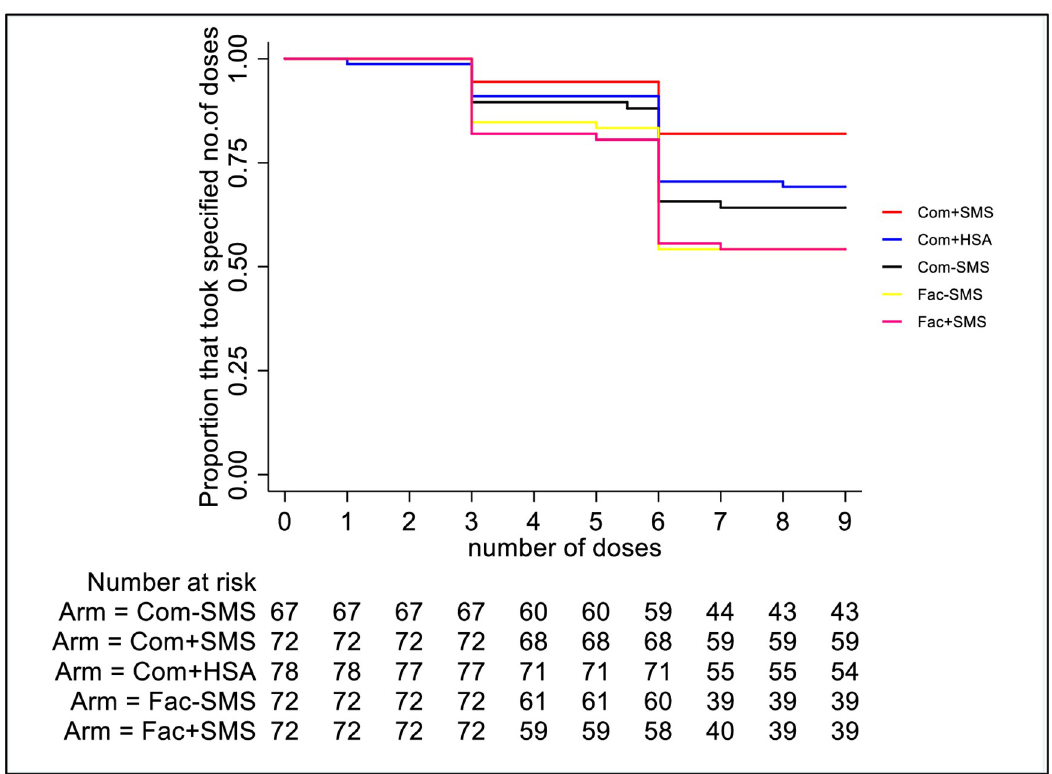
Fig 3. Kaplan Meir curves illustrating the adherence by the total number of PMC doses that were administered in each trial arm.